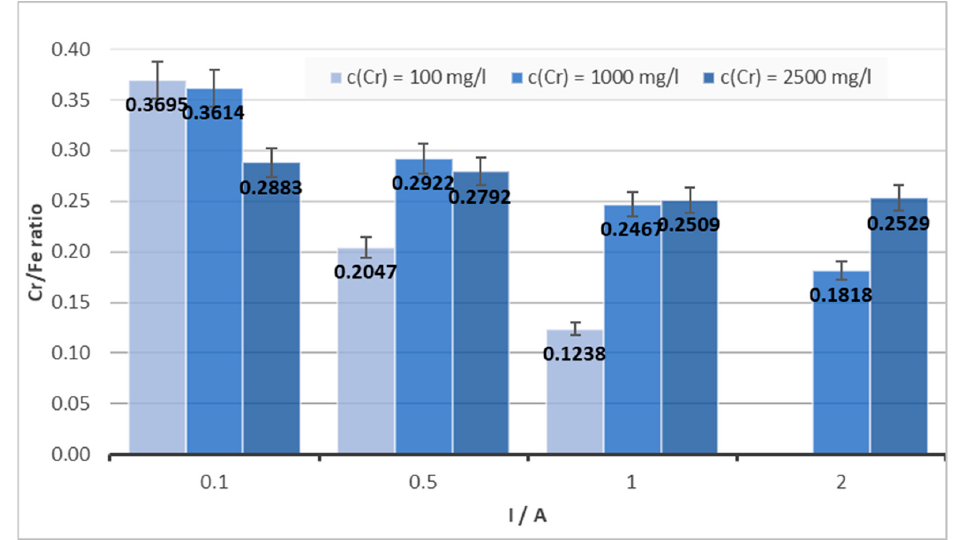
Figure 6. The Cr/Fe ratio’s dependence on amperage for different concentrations of Cr(VI), pH = 6, c (NaCl) = 3000 mg/L.